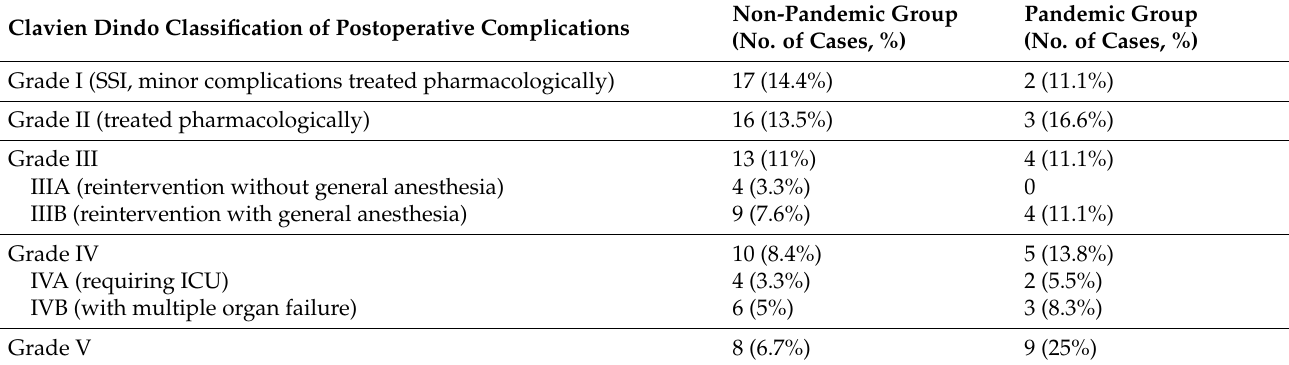
Table 3. Postoperative morbidity in pandemic and non-pandemic groups according to the Clavien Dindo Classification of severity.